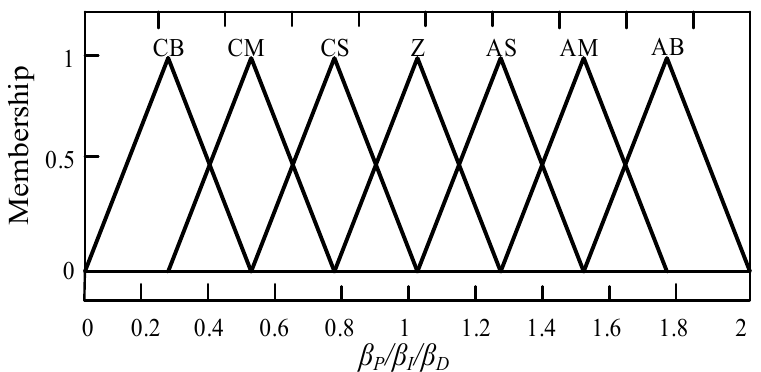
Figure 7. Membership functions of β P , β I , and β D .